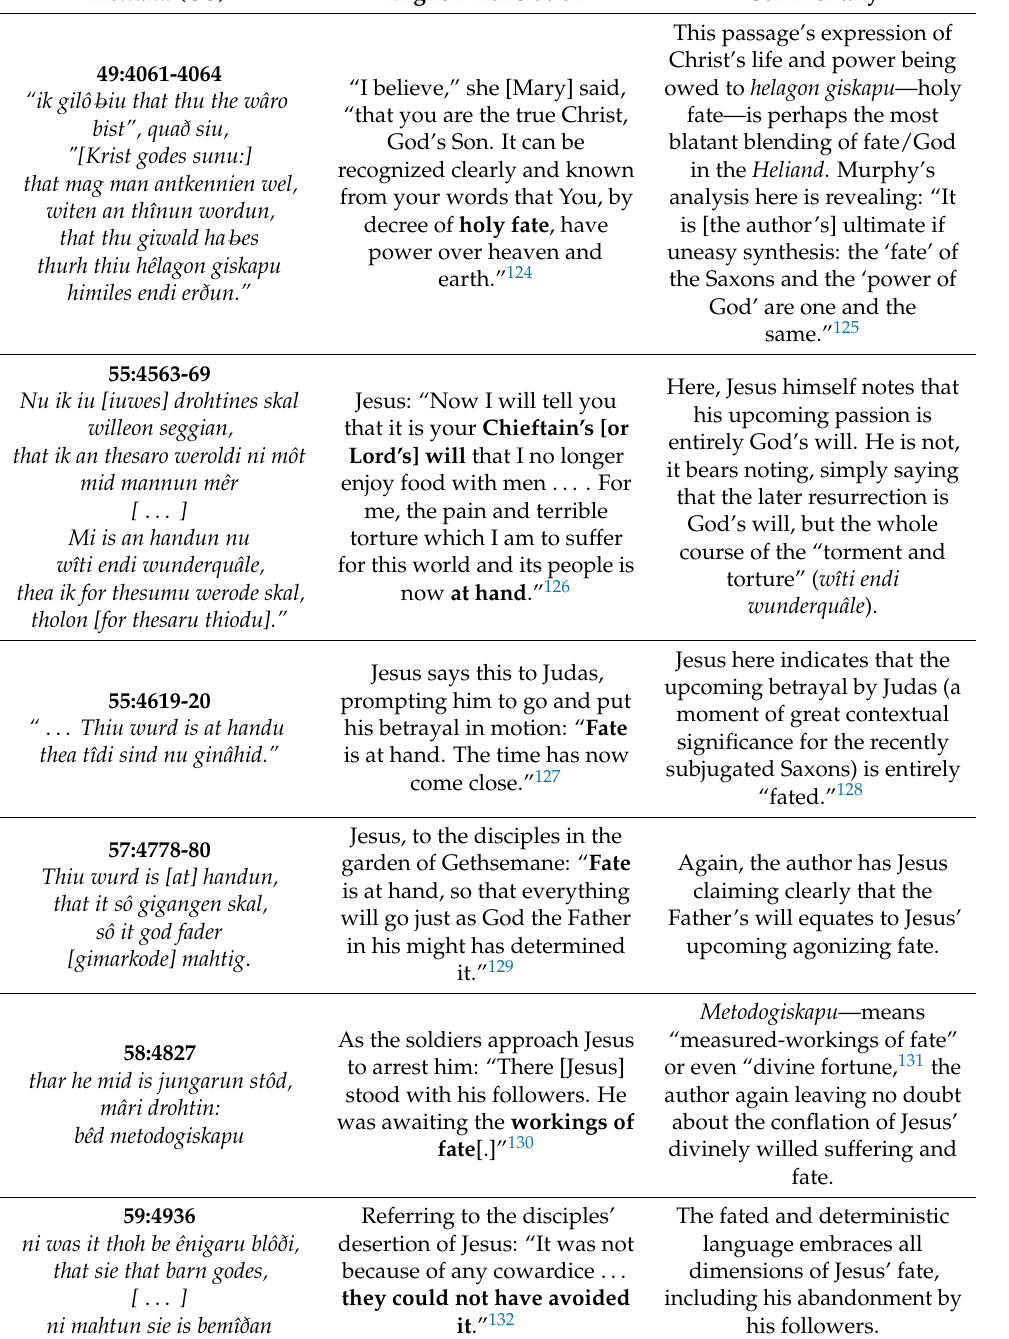
Table 1. Conflation of fate and divine power in the Heliand . Heliand (OS) English